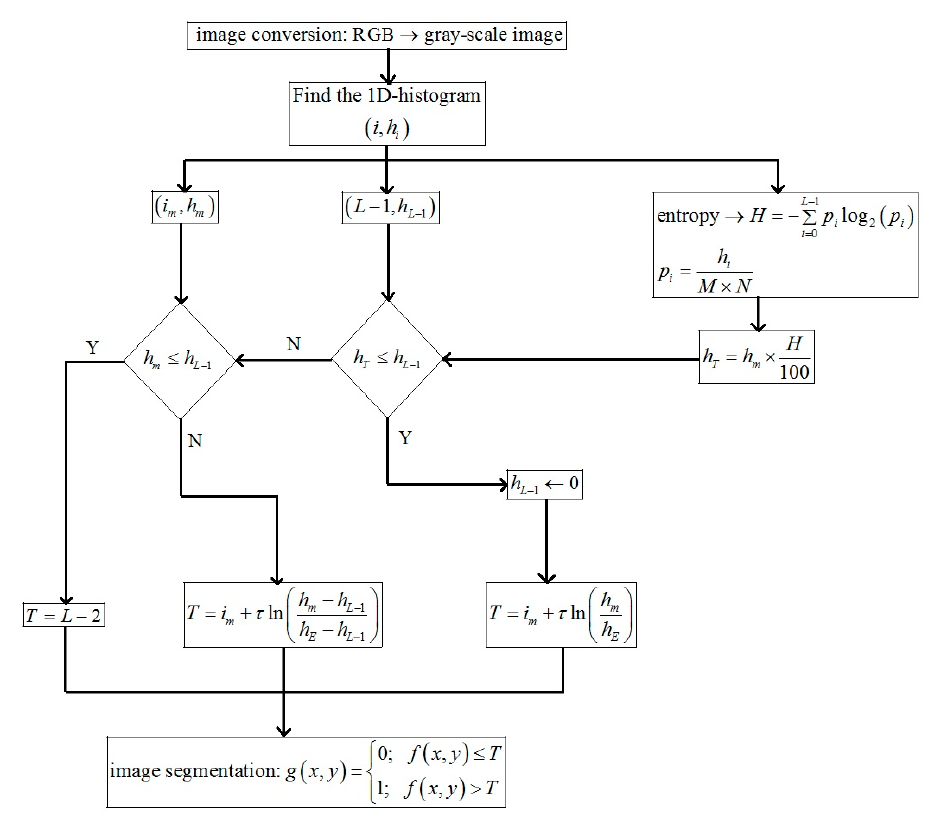
Figure 4. Flowchart of the proposed method to find the threshold value.